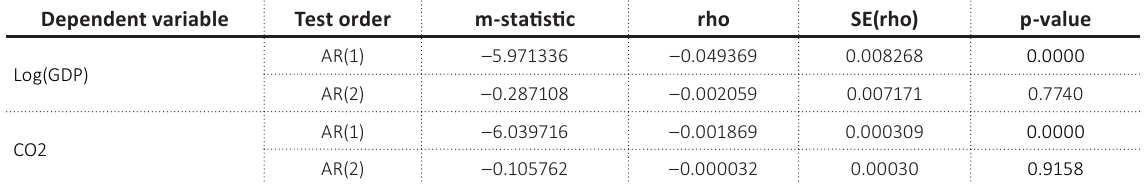
Table 9. Arellano-Bond test’s